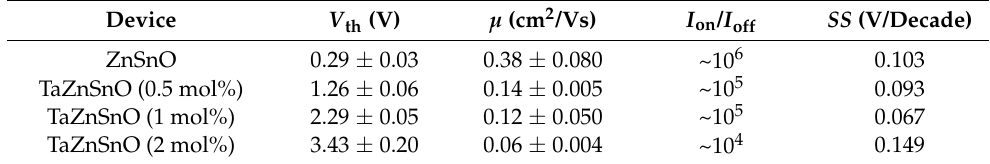
Figure 4. XPS of O1s spectra of the TaZnSnO thin films with different Ta 5+ doping levels of ( a ) 0, ( b ) 0.5, ( c ) 1, and ( d ) 2 mol%. Table 1. Electrical performance of the TaZnSnO TFTs with different Ta 5+ doping